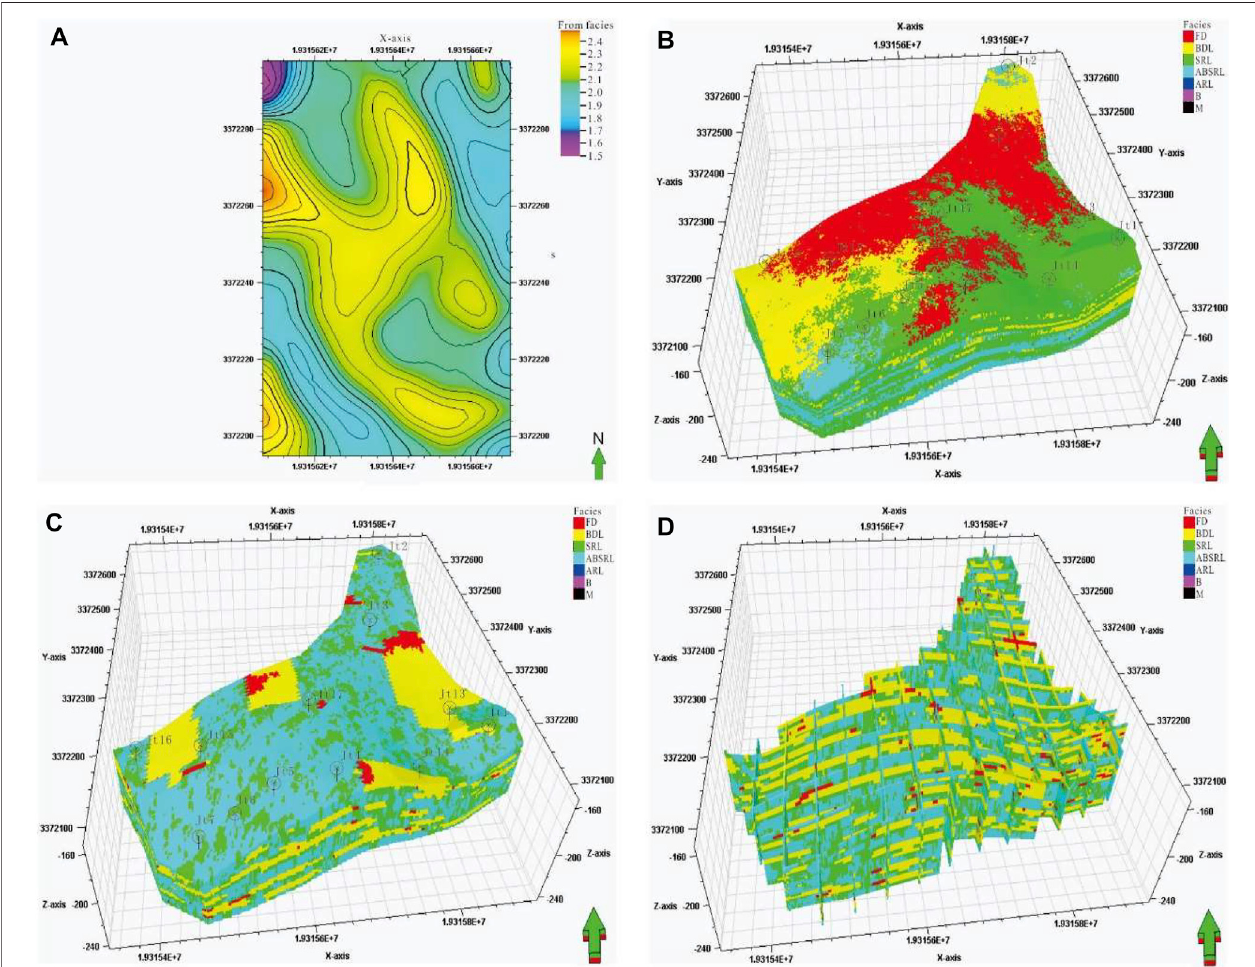
FIGURE14 | 3-D outcrop modeling of reef core microfacies, which are restraint by training image pattern. (A) Reef core training image obtained by SIS, which deposited carbonate lithofacies but poor continuity; (B) the SIS lithological modeling; (C) MPS realization; (D) palisade 3-D grids display about the multipoint geostatistics